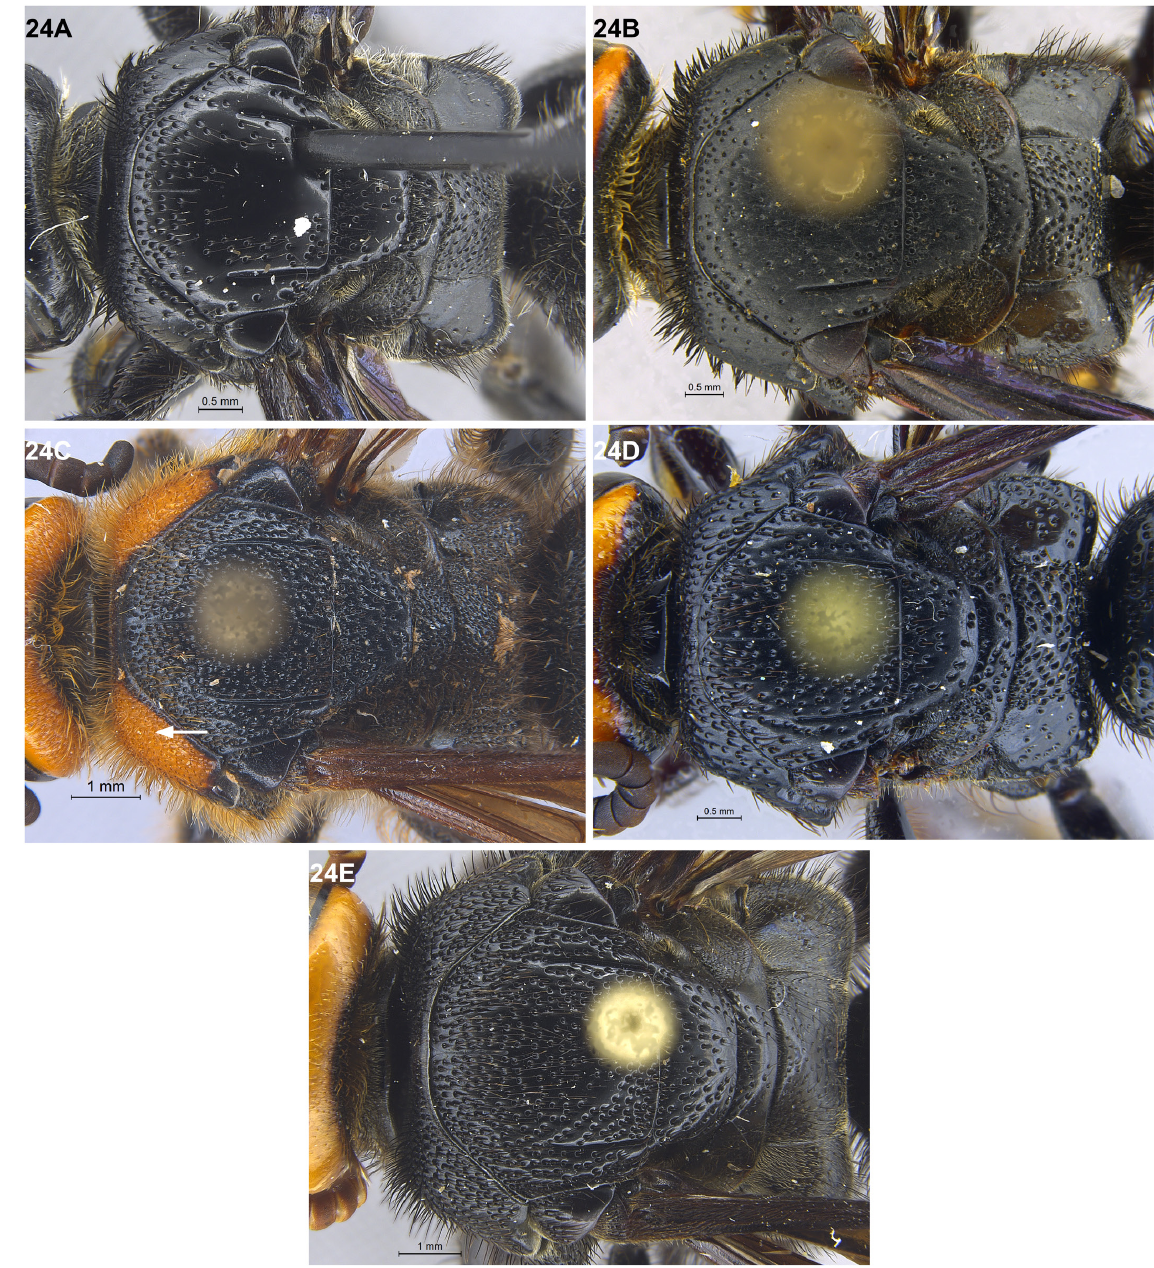
Fig. 24. Females, mesoscutum. A . Scolia binotata Fabricius, 1804 . B . Sc. binotata orange var. C . Sc. clypeata pseudovollenhoveni Betrem, 1933. D . Sc. pakshaoensis sp. nov., holotype (CAS). E . Sc. superciliaris de Saussure & Sichel, 1864